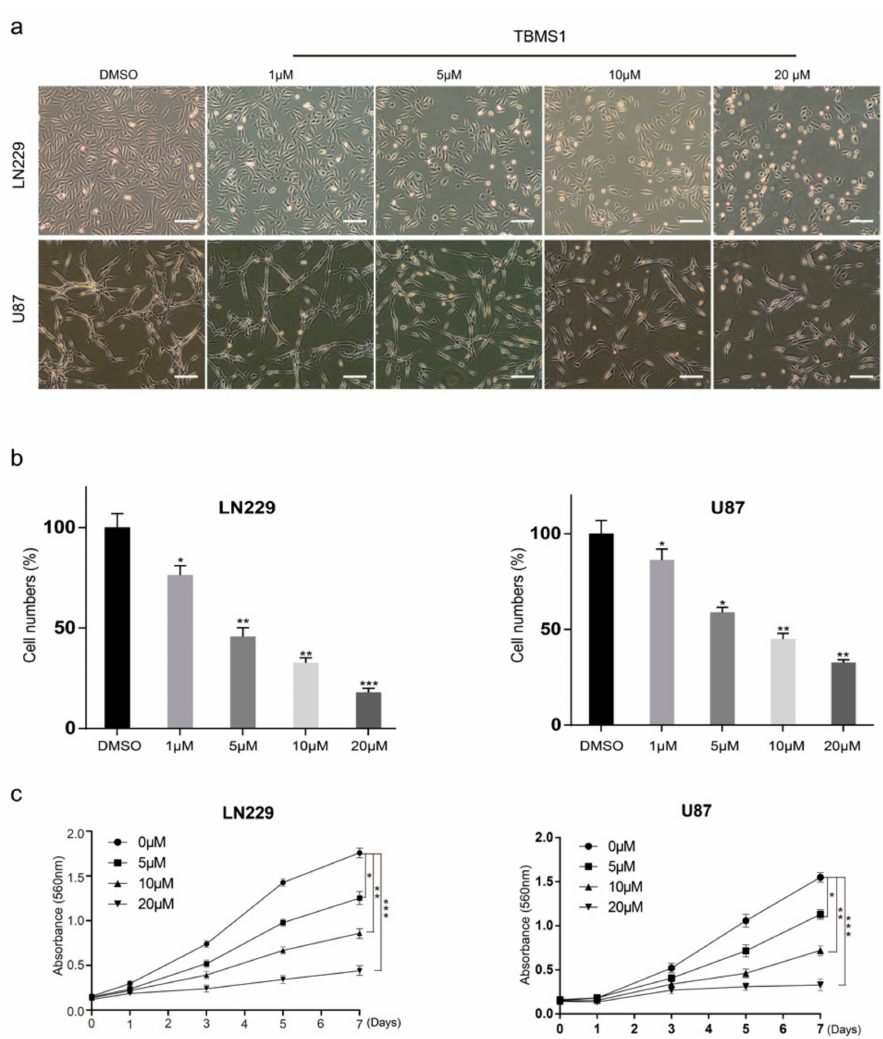
Figure 1. Tubeimoside-1 (TBMS1) inhibits cell proliferation in glioblastoma cells. ( a ) The phenotype of LN229 and U87 cells treated with di ff erent concentrations of TBMS1 for 24 h. DMSO was added as a control, and the scale was 200 µ m. ( b ) Percentage of cells in each group, regard percentage of the cells in the control group as 100%. ( c ) Viability of glioblastoma cells treated with di ff erent concentrations of TBMS1. DMSO was added as a control. * p < 0.05, ** p < 0.01, *** p < 0.001, p -values < 0.05 were considered as statistically